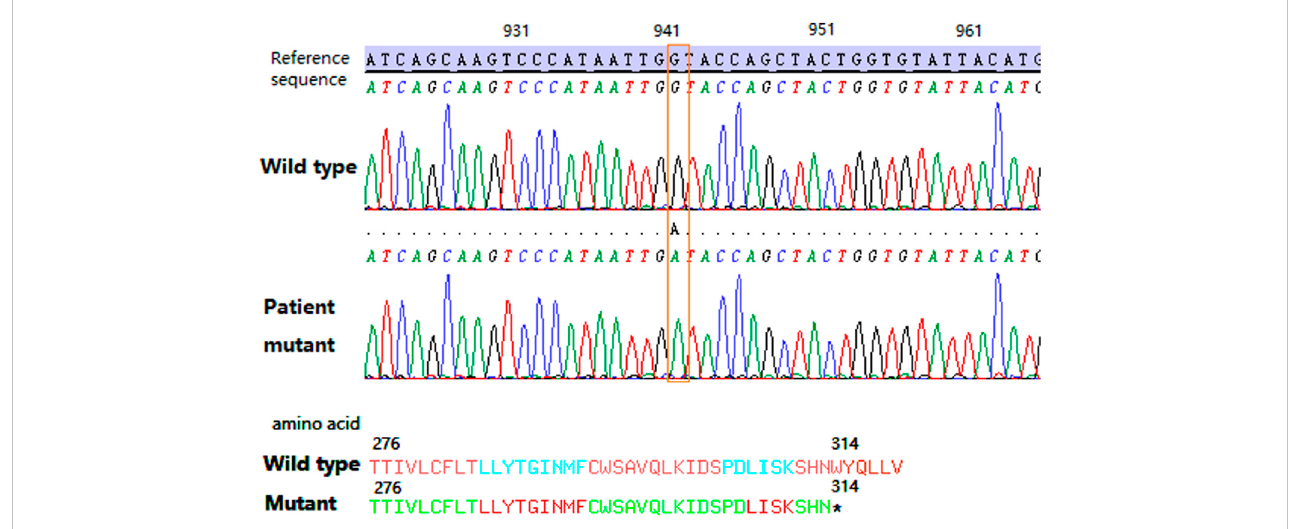
FIGURE 2 Partial sequencing map of the patient ’ s XK gene. The orange dotted box shows the c.942G > A variation. The asterisk shows the tryptophan change to a stop codon located at the 314 position of the XK protein.